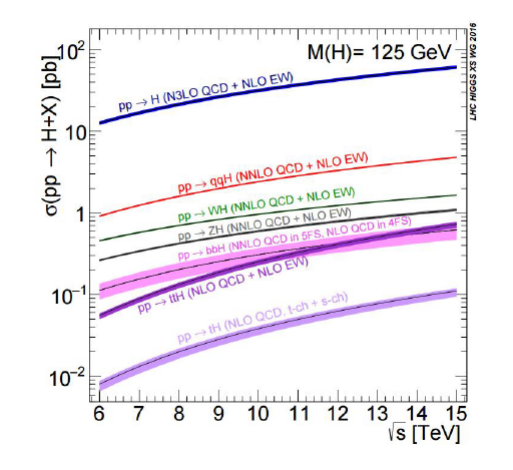
Figure 1. Energy dependence of the cross-section of the Higgs boson production in proton-proton collisions.